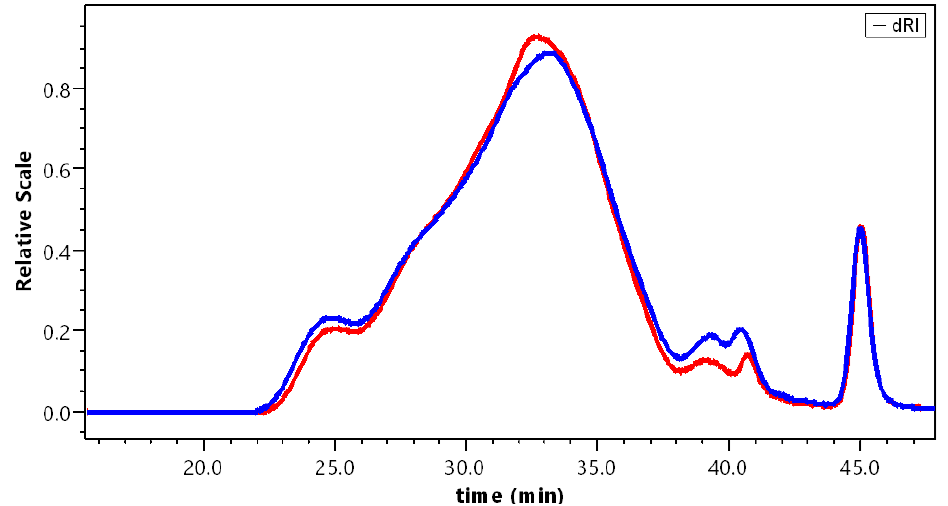
Figure 3. Reproducibility test: SEC chromatograms for two APP preparations dissolved in 0.1 mol L −1 NaNO 3 .